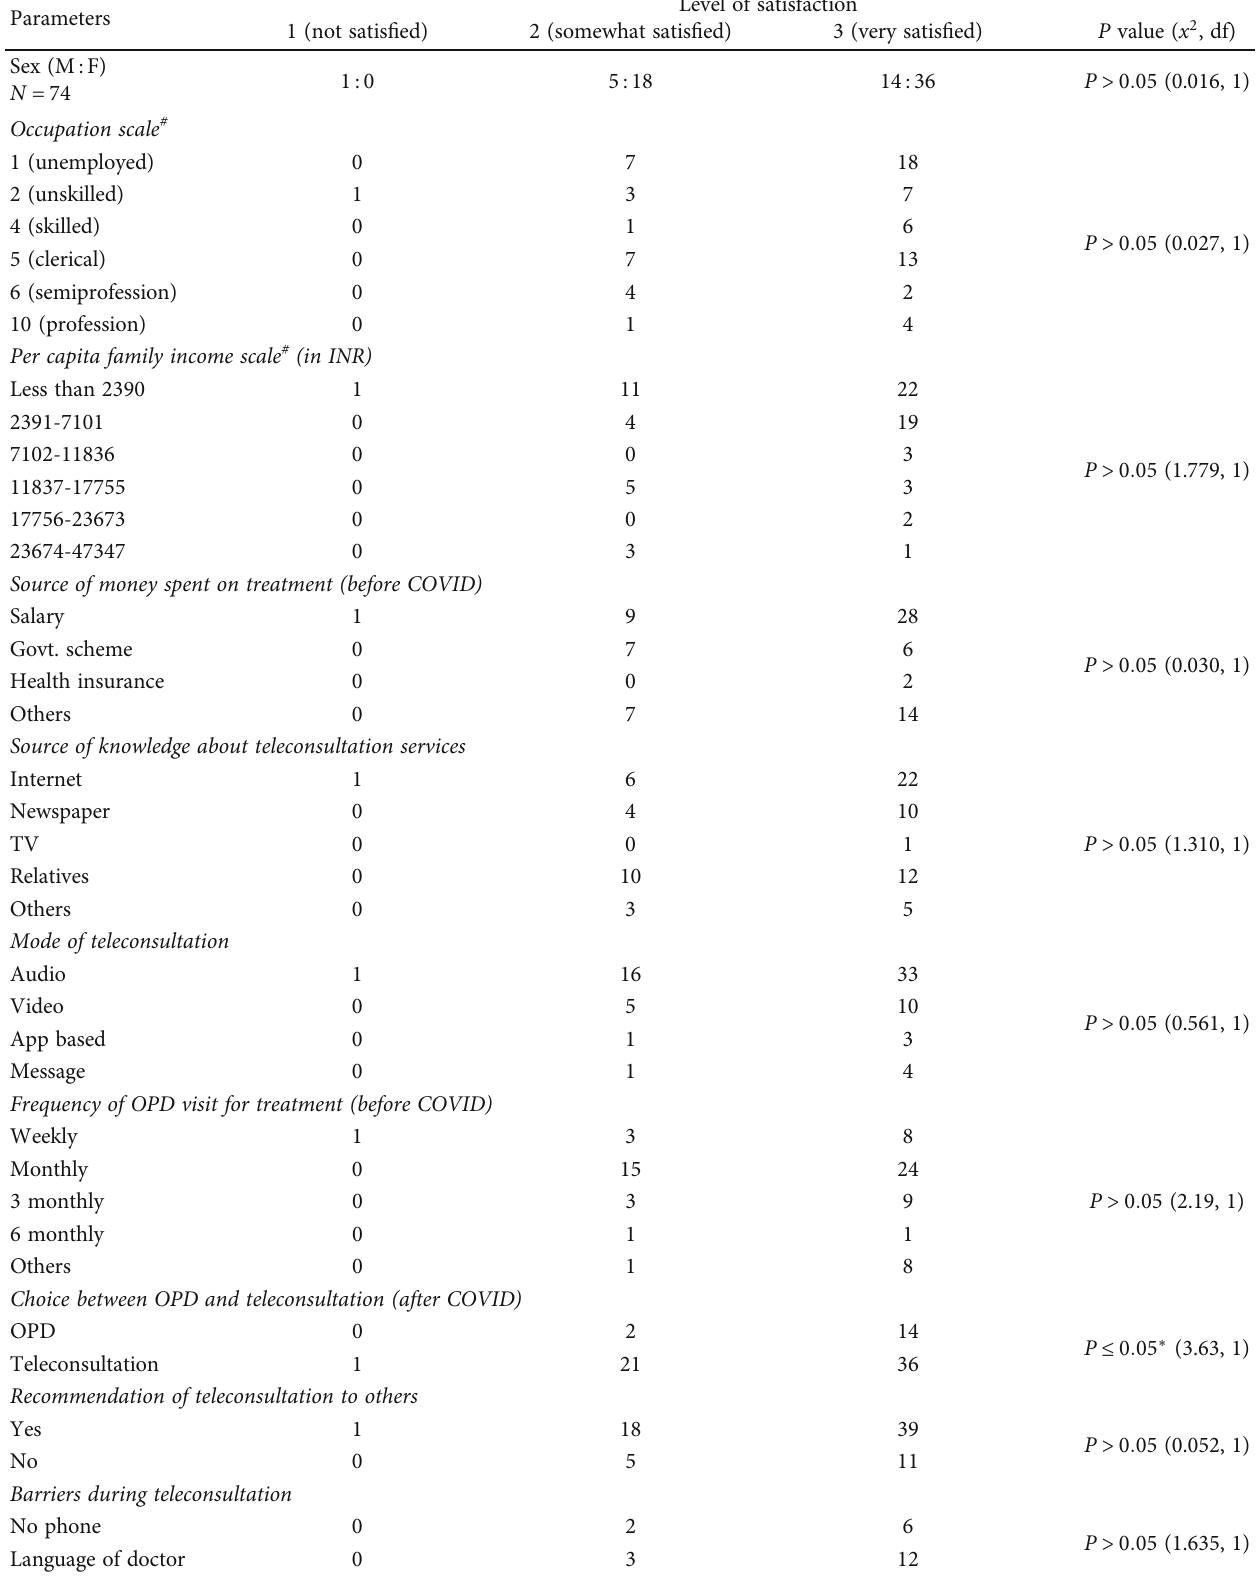
Table 2: Demographic